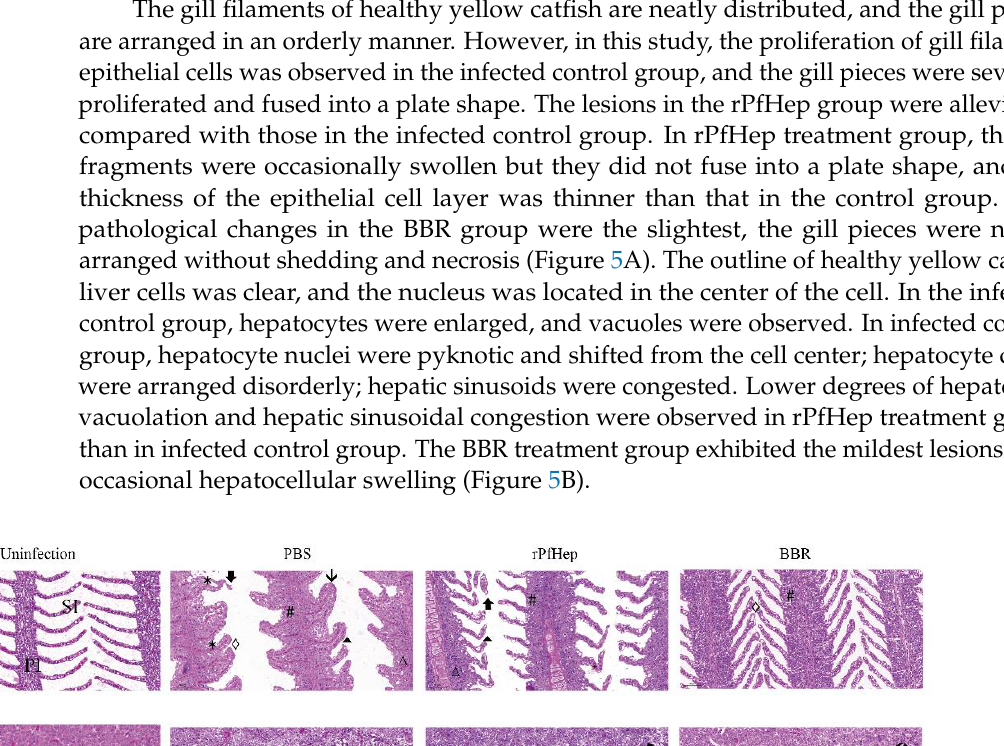
Antibiotics 2021 , 10 , x 7 of 16 2.5. Alleviation of A. veronii-Induced Inflammation by rPfHep and BBR